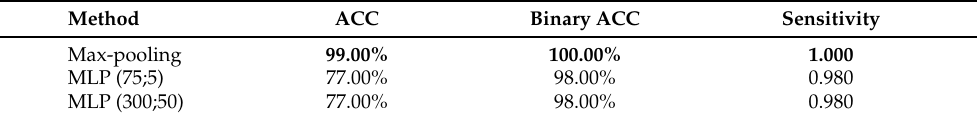
Table 6. Model performance evaluation on the PAIP test set. In bold are the best results per